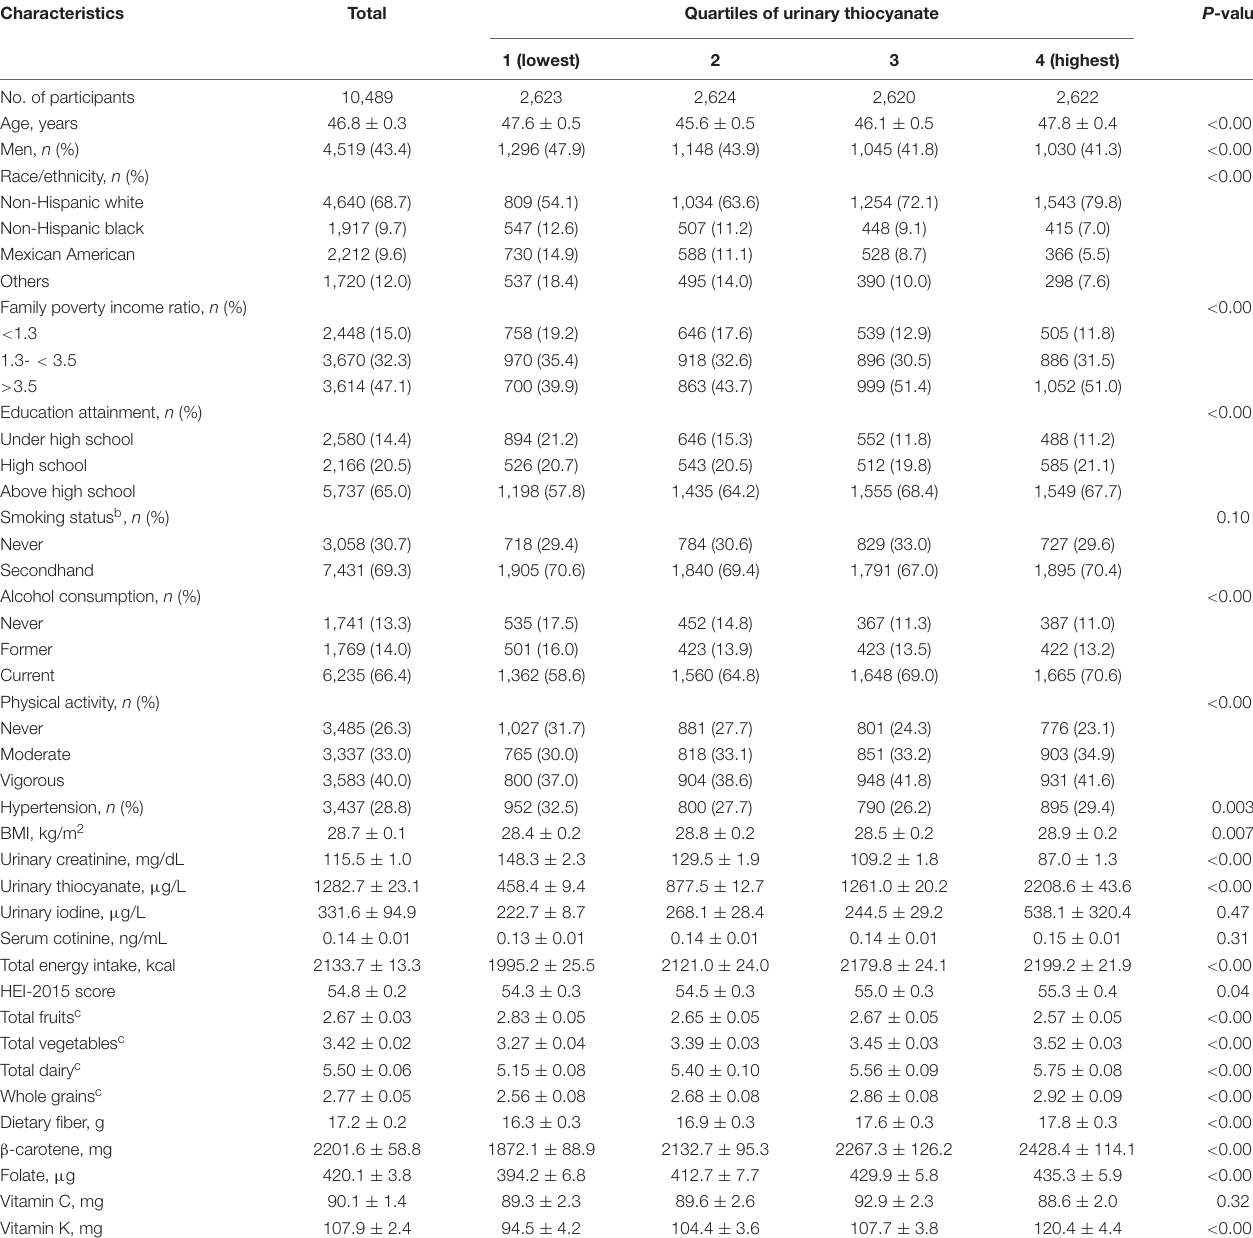
TABLE 1 | Characteristics of study population according to quartiles of urinary thiocyanate a .